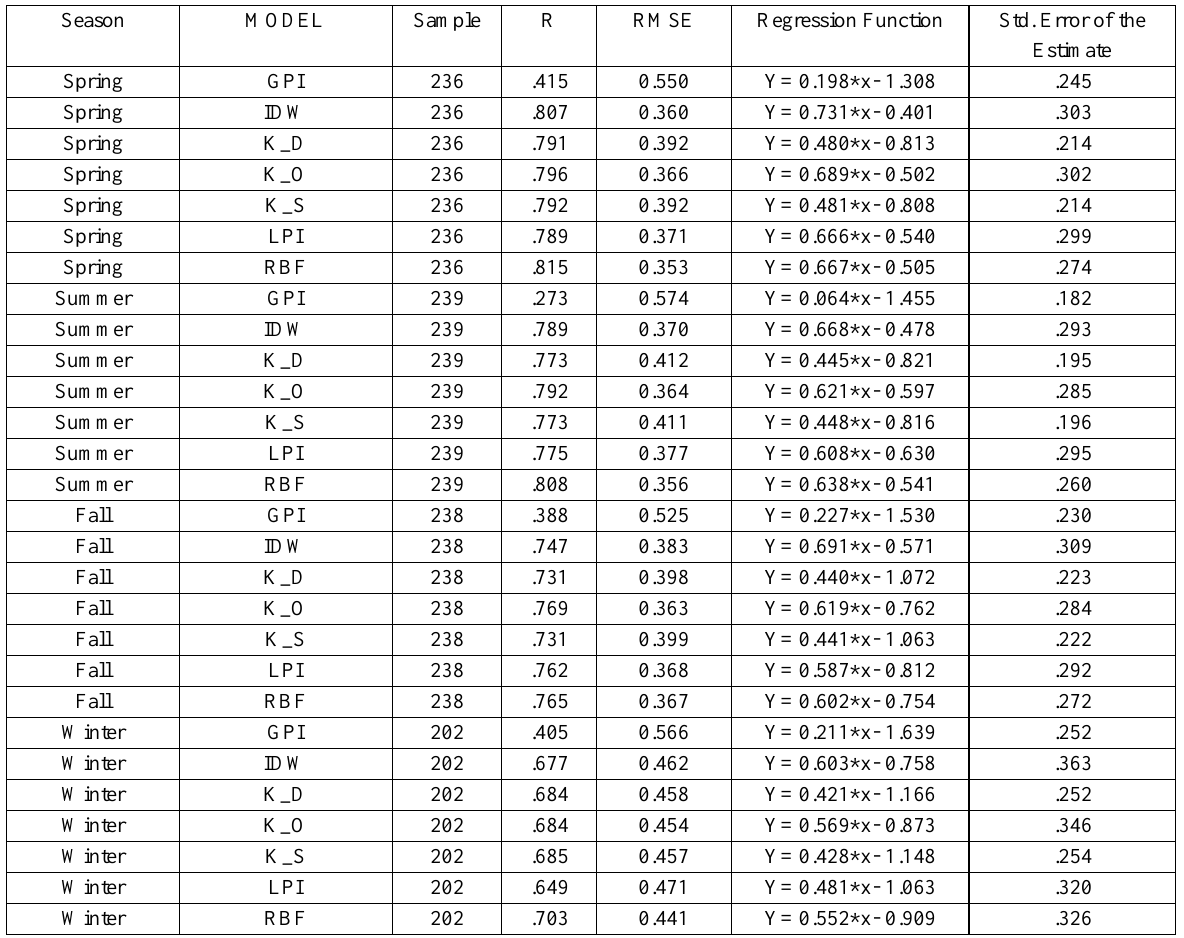
Figure 2. Histograms of raw values of mean AOD Table 2: R and RMSE for eight methods for